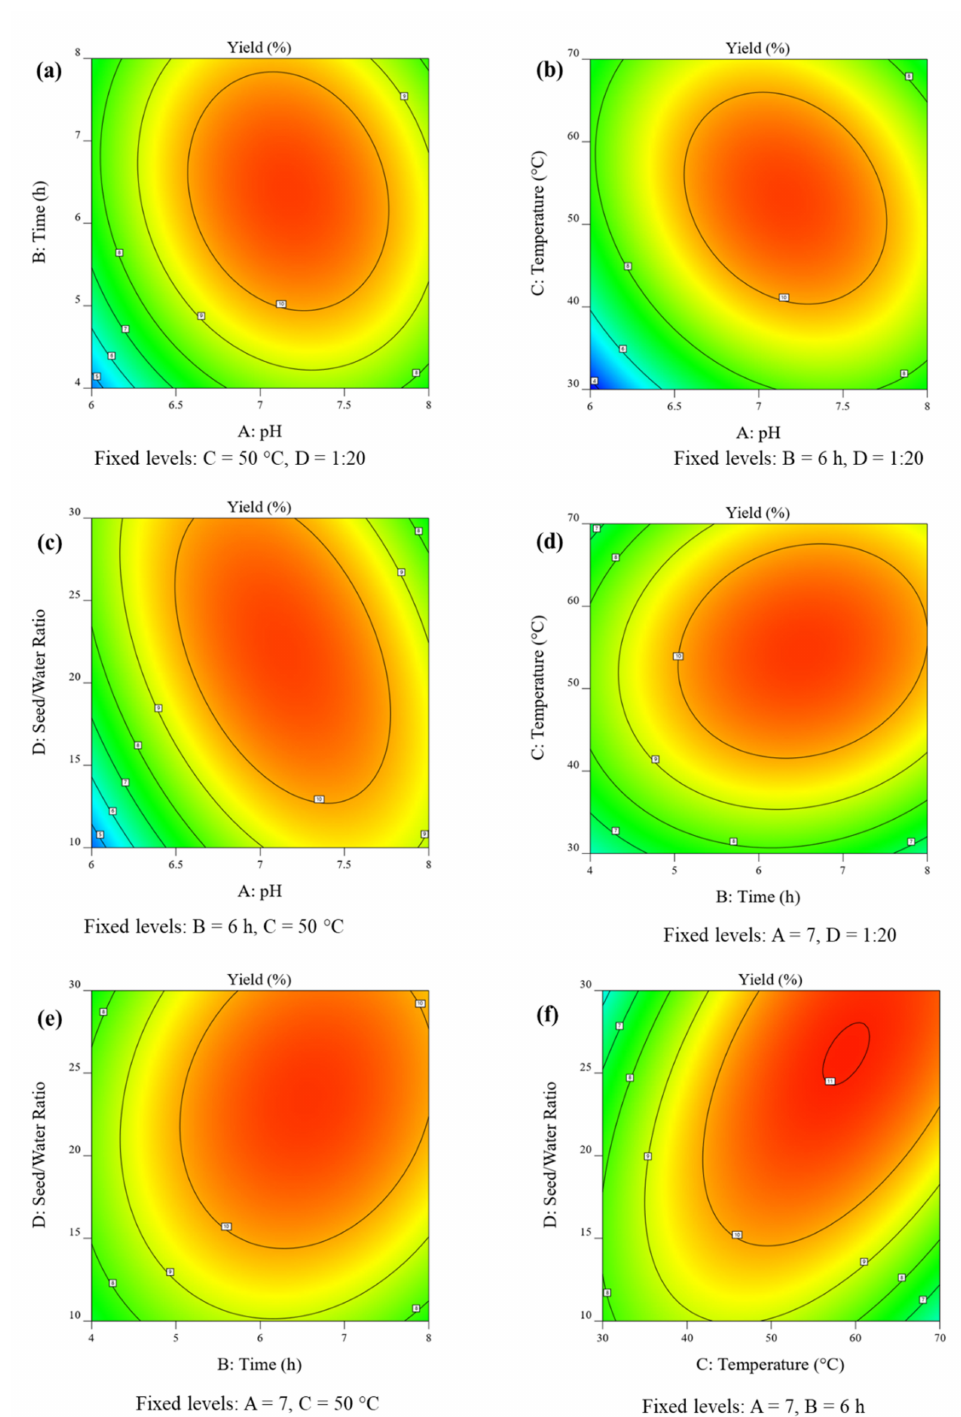
Figure 3. 2D contour plots pH vs. contact time ( a ), pH vs. extraction temperature ( b ), pH vs. seed/water ratio ( c ), contact time vs. extraction temperature ( d ), contact time vs. seed/water ratio ( e ), and extraction temperature vs. seed/water ratio ( f ), showing significant interaction effect on the yield of MPM (%) from MP